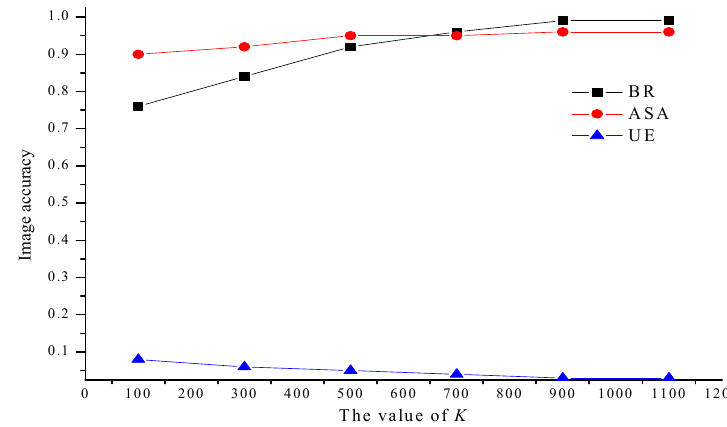
Figure 5. The effect of the initial number of superpixels K on image accuracy. Figure 5. The e ff ect of the initial number of superpixels K on image